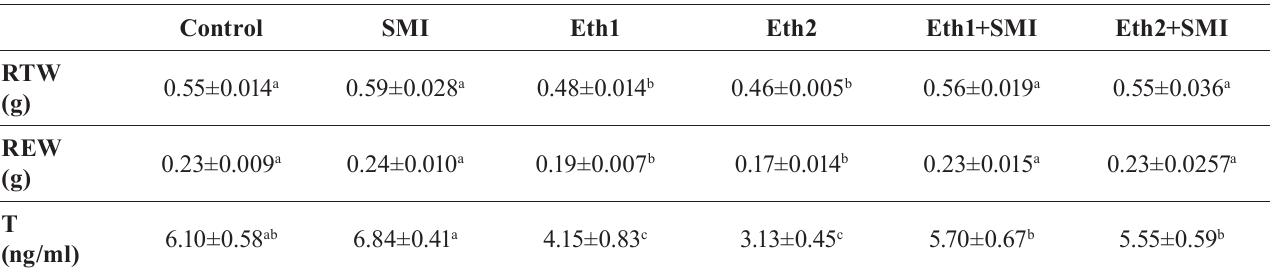
TABLE II - Values of the reproductive indices (testis and epididymis weight, and plasma testosterone concentration) of Wistar rat expressed as mean ± SD after six consecutive weeks of treatment Control SMI Eth1 Eth2 Eth1+SMI